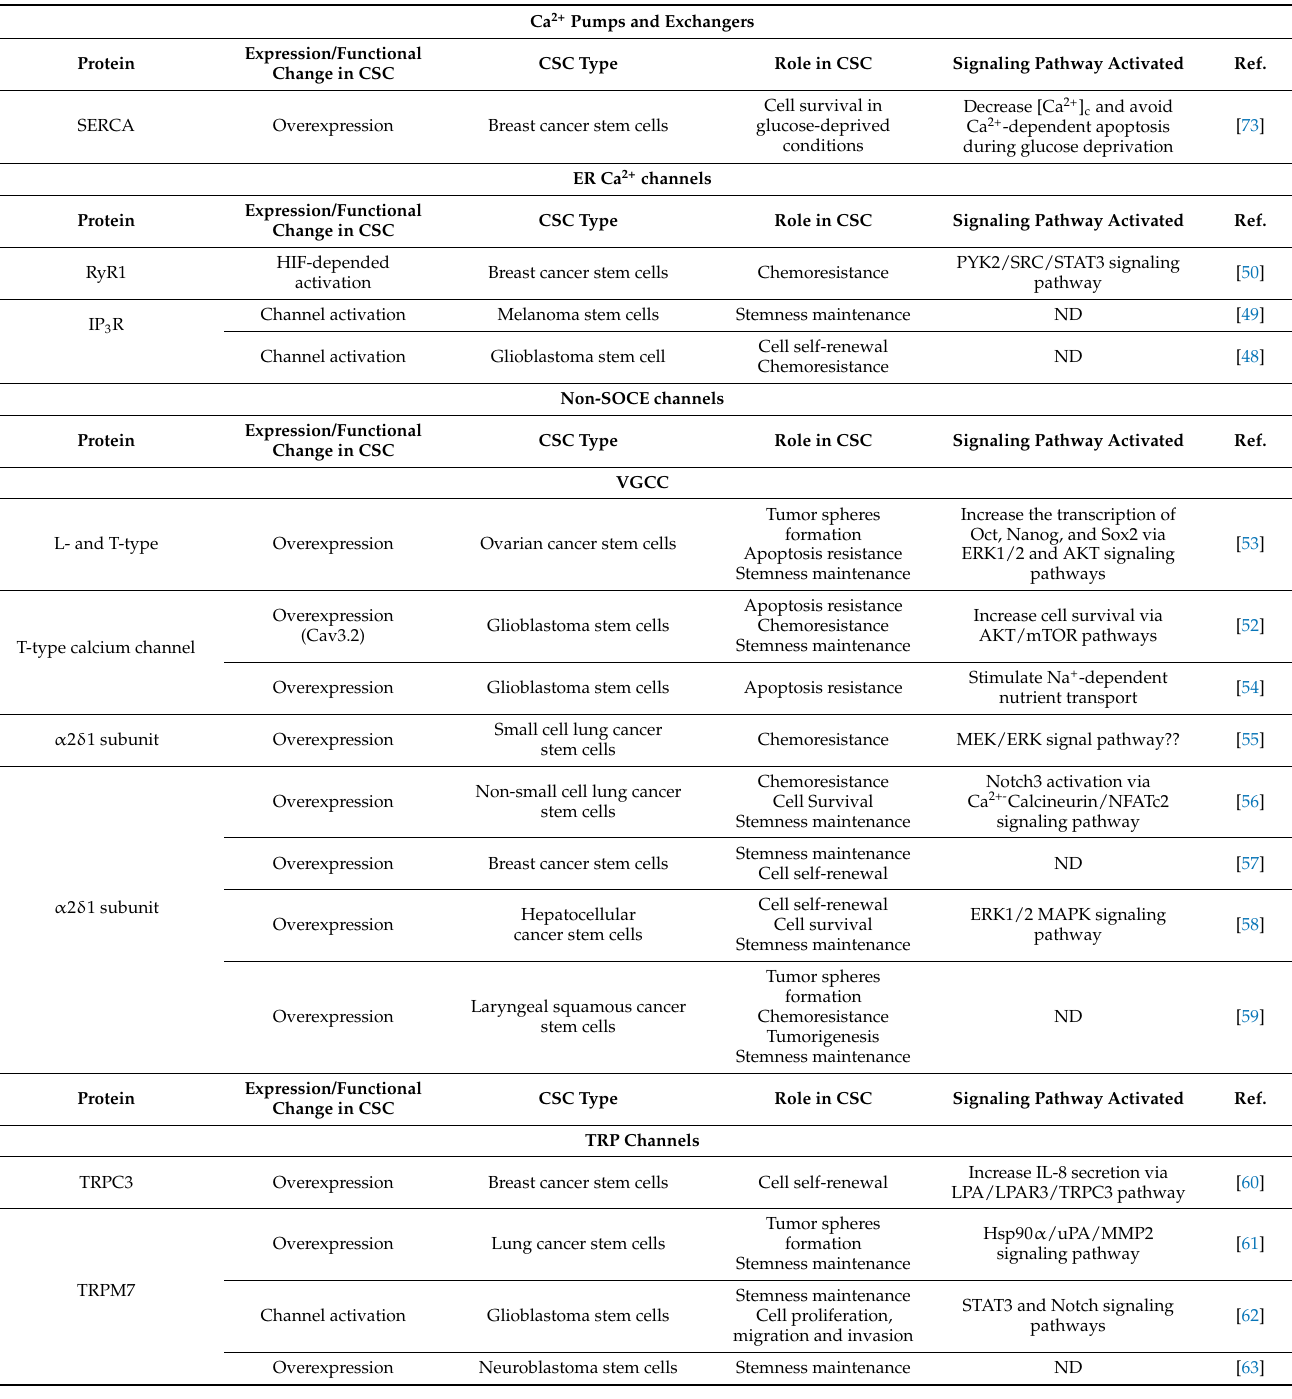
Table 1. Implications of calcium-related proteins in cancer stem cells. ND: not determined. VGCC: voltage-gated calcium